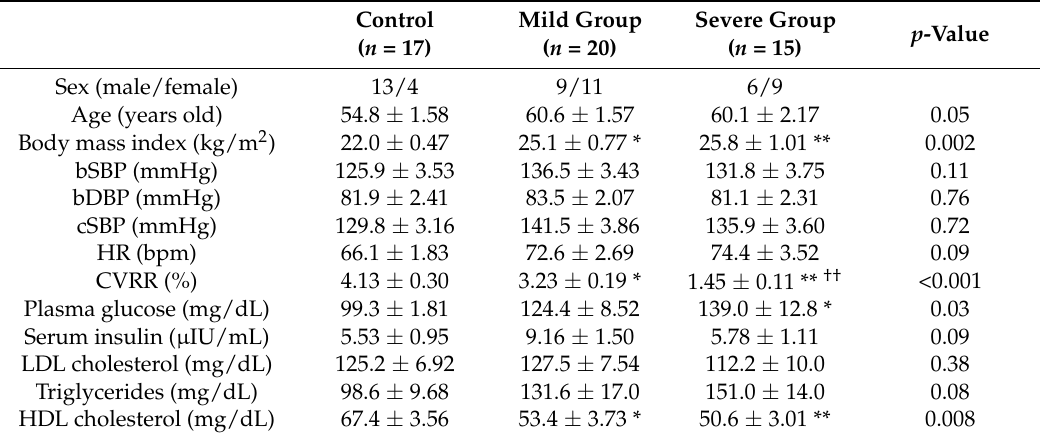
Table 1. Baseline characteristics.